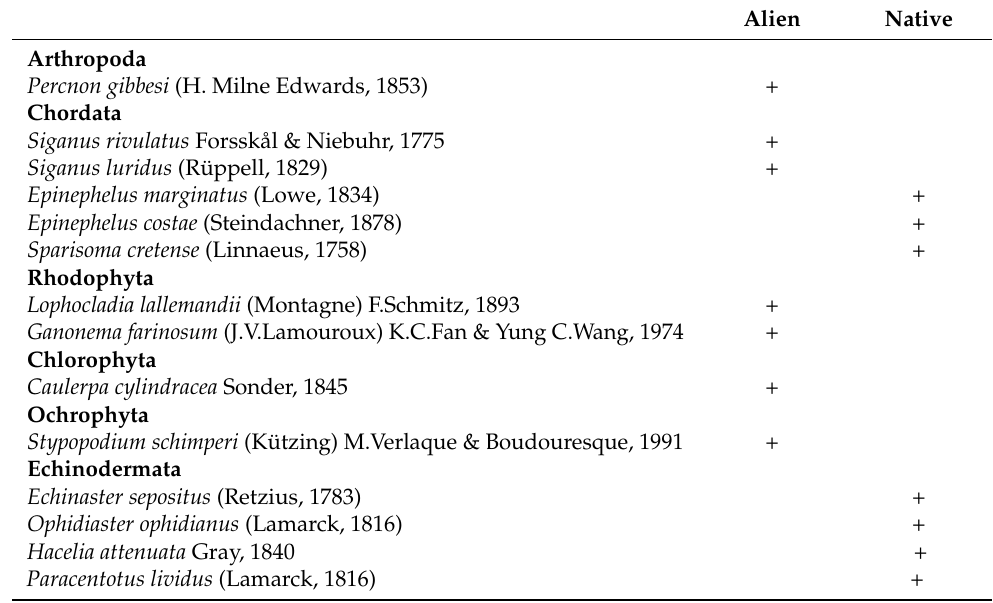
Table 1. List of the targeted megabenthic and necto-benthic species (+ sign indicates whether a species is alien or native).